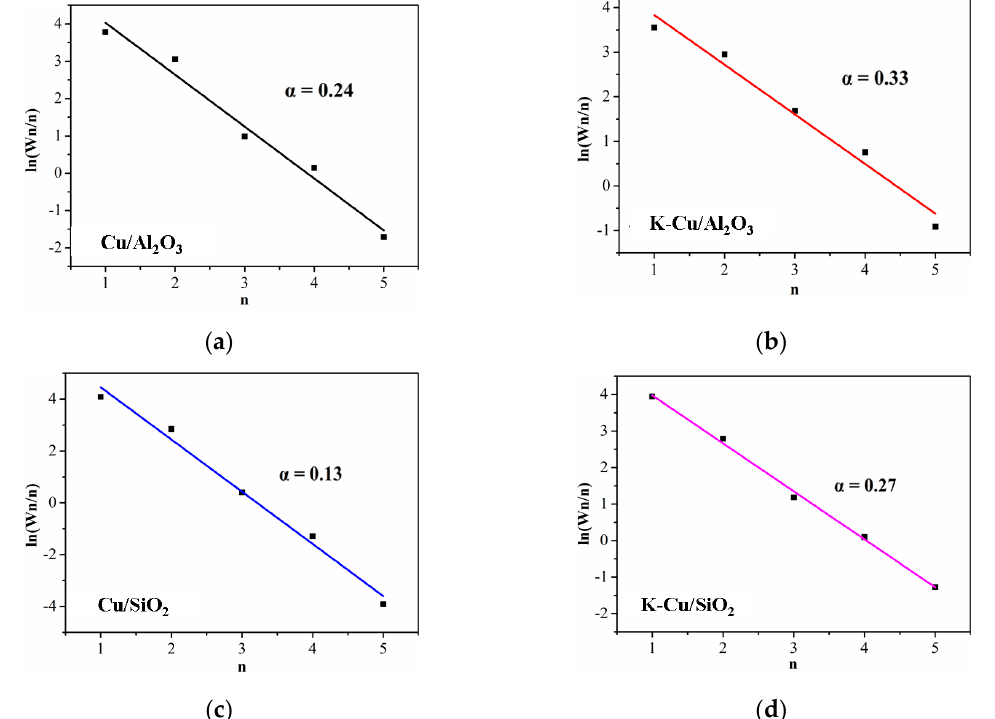
Figure 9. Anderson-Schulz-Flory (A-S-F) plots for the distribution of alcohols for catalysts: ( a ) Cu/Al 2 O 3 , ( b ) K-Cu/Al 2 O 3 and ( c ) Cu/SiO 2 , ( d ) K-Cu/SiO 2 . Wn = n × (1 − α ) 2 × α n − 1 , where Wn stands for the mass fraction of alcohols containing n carbon atoms.